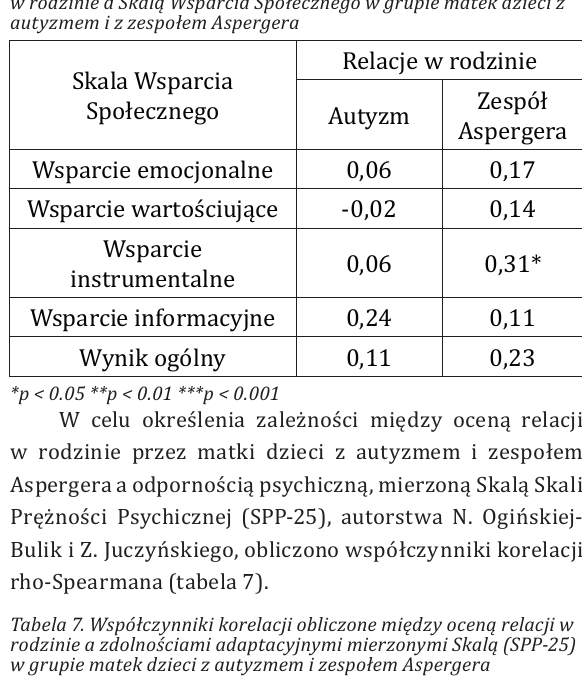
Aspergera Kwestionariuszem Orientacji Życiowej SOC-29, autorstwa A. Antonovsky’ego, obliczono współczynniki korelacji rho- Tabela 5. Współczynniki korelacji obliczone między oceną relacji Spearmana (tabela 5). w rodzinie a poczuciem koherencji mierzonym kwestionariuszem SOC-29 w grupie matek dzieci z autyzmem i zespołem Aspergera